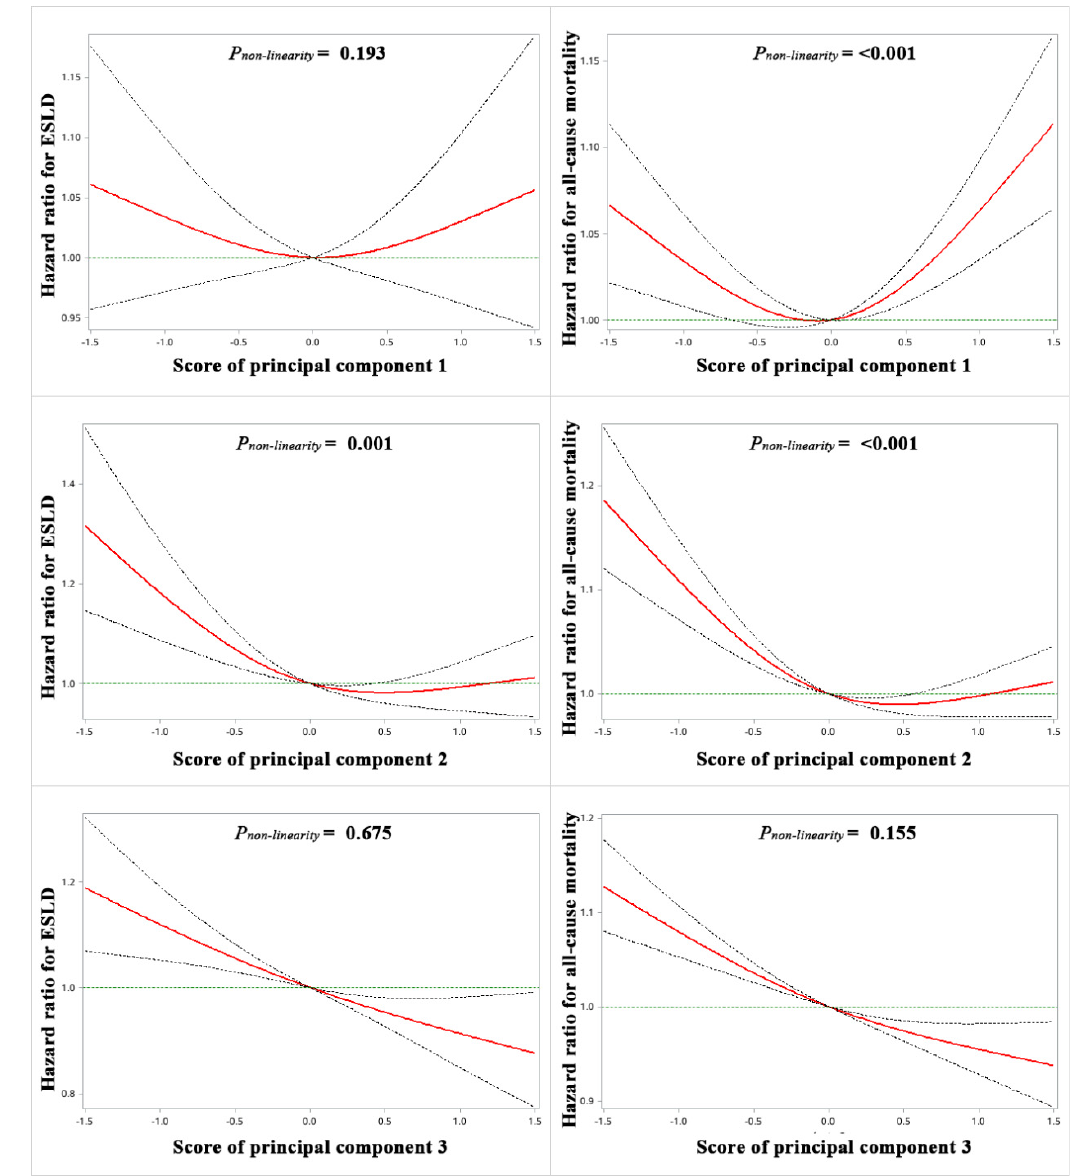
Figure 3. Restricted cubic spline analyses of the relationship between dietary patterns and the incidence of end-stage liver disease (ESLD) and all-cause mortality. Red lines represent adjusted hazard ratios [with 95% CI (dashed lines)] based on restricted cubic splines with knots at the 10 th , 50 th , 90 th . The model was fully adjusted. Principal component 1: meat; principal component 2: prudent; principal component 3: high-quality carbohydrate.